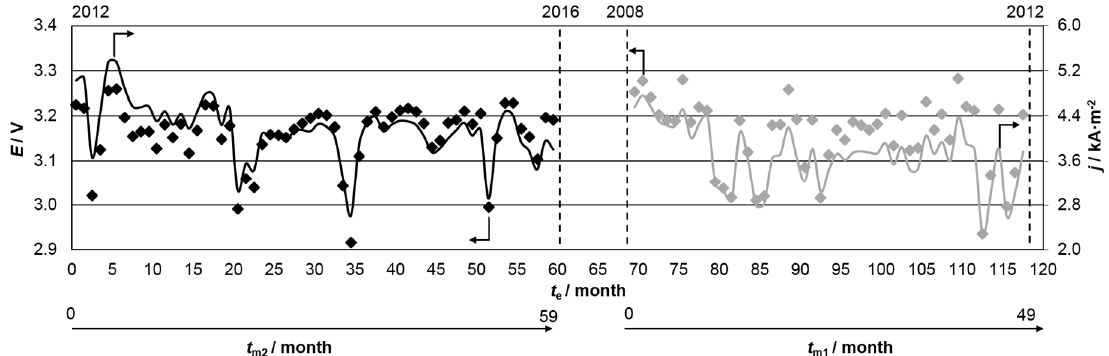
Figure 2. Potential ( ♦ ), E , and current density (-), j , as a function of the electrode and membrane service times, respectively t e and t mi .